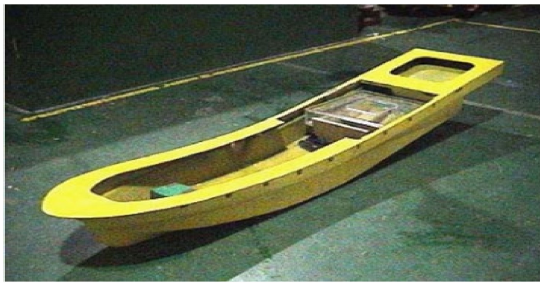
Figure 20. Model of a testing vessel